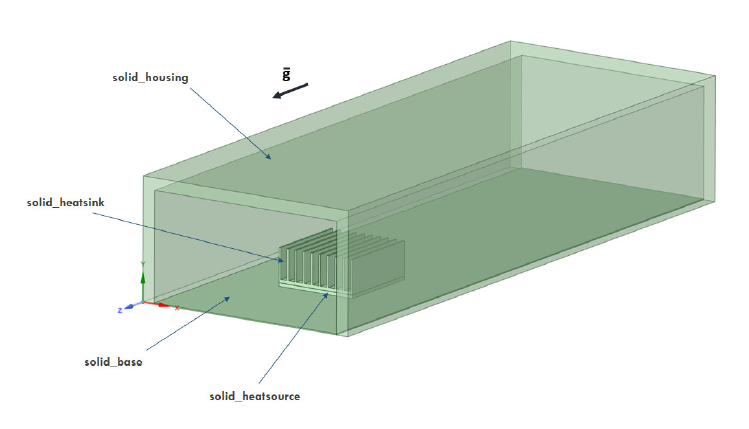
Figure 2. Geometric model of the cooling system with names of individual parts.